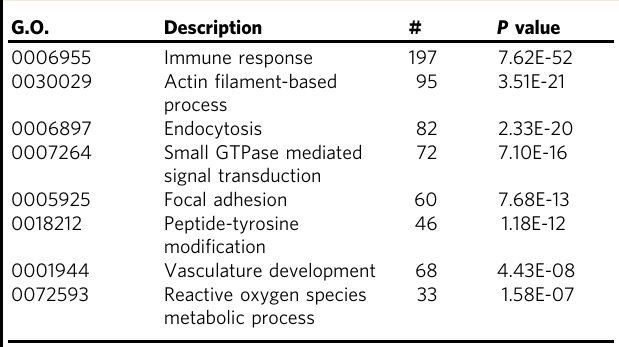
Table 3 XY vs XX liver transcriptional pathway over-representation